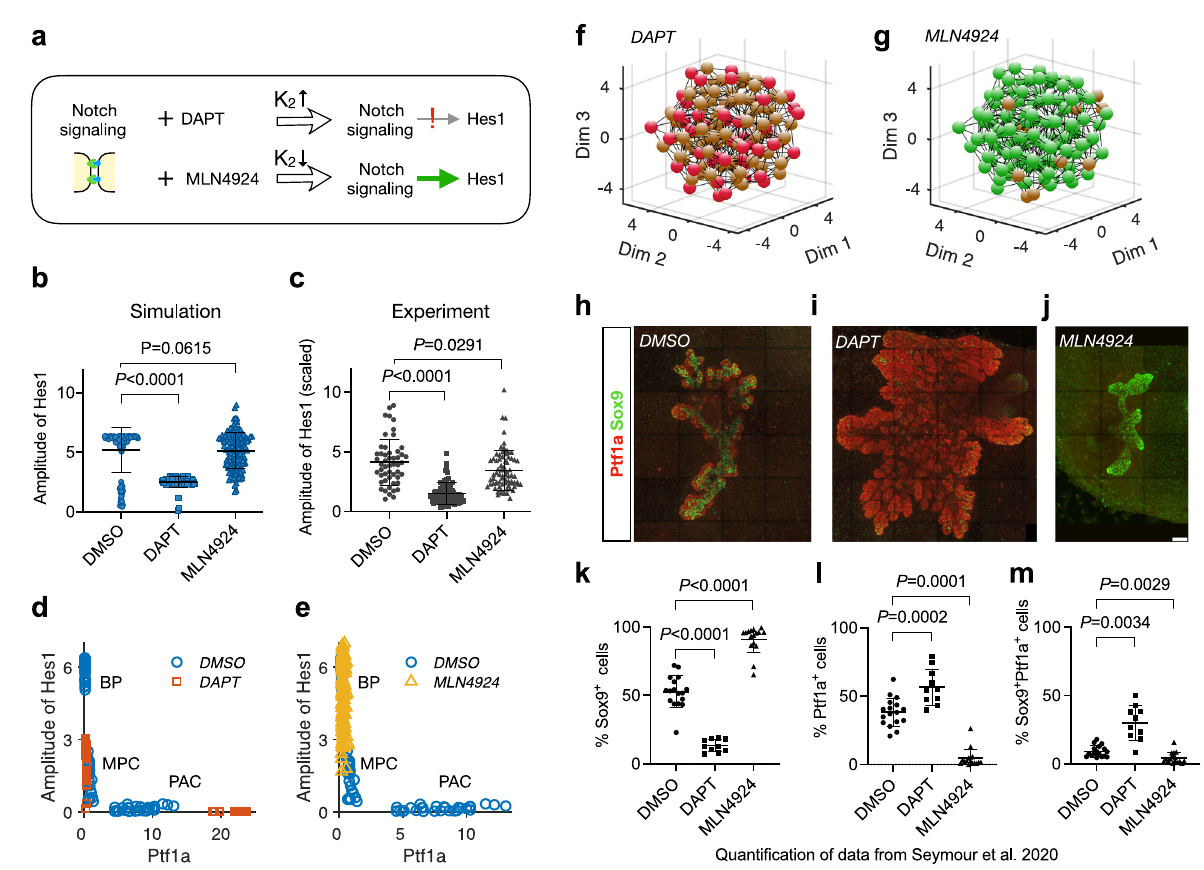
Fig. 4 | Alteration of Hes1 transcription biases cell proportions. a Effects of DAPTorMLN4924onHes1 expressioncorrespond toincreasing ordecreasingthe parameter K 2 in the model. b Model predicted effects of treatment with DAPT or MLN4924 on amplitude of Hes1 expression. Values of K 2 in different conditions: DMSO( K 2 =0.06),DAPT( K 2 =0.3),andMLN4924( K 2 =0.01).Mean±SD, N =115for DMSO, N =91forDAPT,and N =143forMLN4924. P valuesarecalculatedwithtwo- tailed Mann – Whitney test and shown above the sample pairs. c Experimentally observed relative changes by treatment with DAPT or MLN4924 on the amplitude ofHes1expression.Datafromref. 16 areplotted(Mean±SD, N =51forDMSO, N =71 forDAPT, N =74forMLN4924),andtheoriginalluminescencesignalisscaledwith 10 4 . P values are calculated with two-tailed Mann – Whitney test and shown above thesamplepairs. d AmplitudeofHes1andPtf1alevelchangeswithDAPTtreatment in simulation. Treatment with DAPT is predicted to lead to failure of cell fate segregationand resultin morecells maintaining MPC state.In the simulation, 24% of the cells adopt PAC fate, which is slightly higher than DMSO (20%). DMSO: